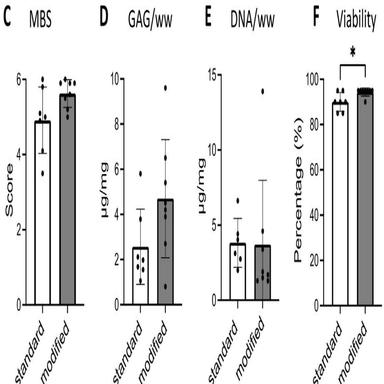
Histological analysis (Safranin-O, Saf-O, top pictures and type II collagen, Col2, bottom pictures) of the N-TEC generated with the modified process using cells from five donors (A). Staining of worst- and best-quality N-TEC generated with the standard process and representative staining of N-TEC generated with P2 or P4 cells with the modified process. Histological slides are oriented in the way to have on the top view the newly deposited cartilage matrix (in the seeded cell-permeable layer of the Chondro-G